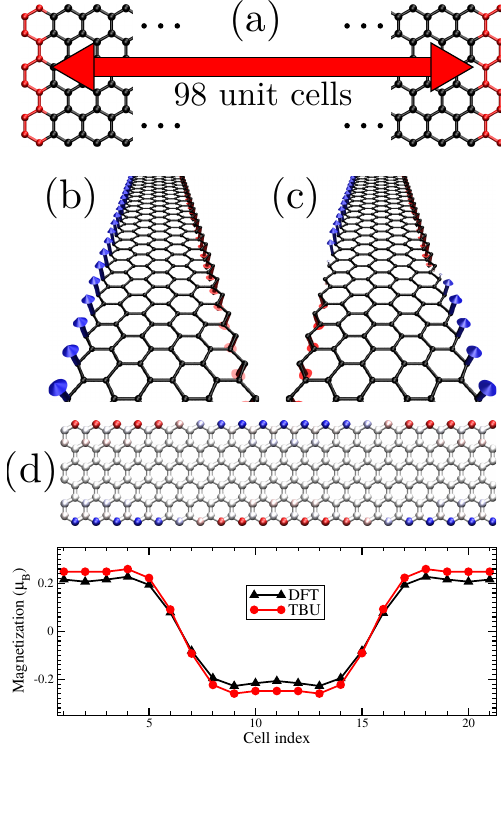
Figure 1. ( a ) Atomic structure of a periodic zigzag-edged graphene nanoribbon (zGNR)- n , where n is the number of zigzag strips along its width ( n = 6 in this example). M = 98 unit cells are used as the spin-relaxation region sandwiched between two semi-infinite leads with spin distributions matching those of the bulk AFM state (the leads unit cells are highlighted in red). The relative orientation between the distributions in the two leads can be either the same ( b ) to form a pristine homojunction; or opposite ( c ) to form an heterojunction. ( d ) A comparison between tight-binding + Hubbard (TBU) and density functional theory (DFT) calculations for the spin polarization along the edge for a system composed of 18 unit cells of a zGNR-6 (the supercell used in the calculation is highlighted by a black rectangle), where cells numbered 1–3 and those running from 10–12 are constrained to retain the bulk AFM spin distributions in opposite orientations, as in (c). Here, red and blue colors for edge atoms represent the opposite spin